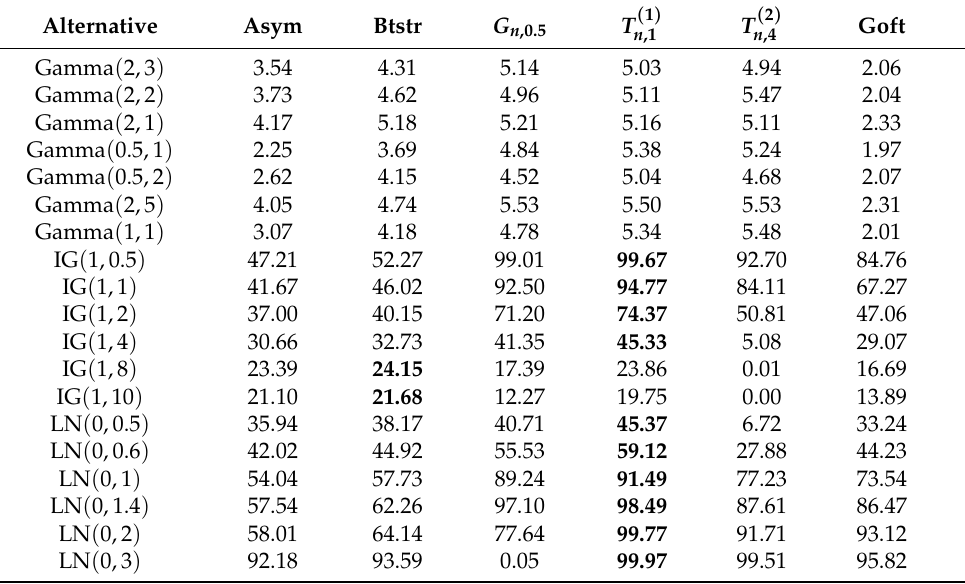
Table 2. Percentage of 10,000 Monte Carlo samples declared to be significant by various tests for the gamma distribution ( n = 100, α = 0.05). MLE ˆ ν was